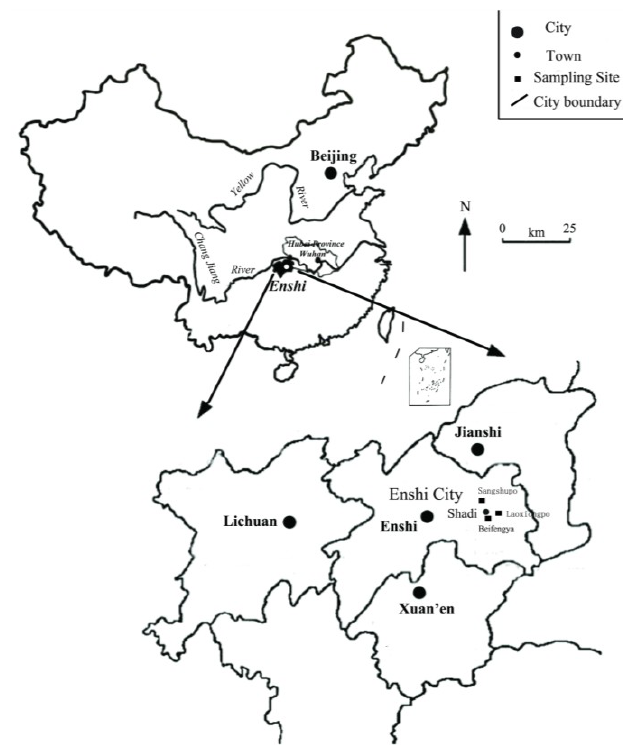
Figure 1. Research location of Shadi town of Enshi city,